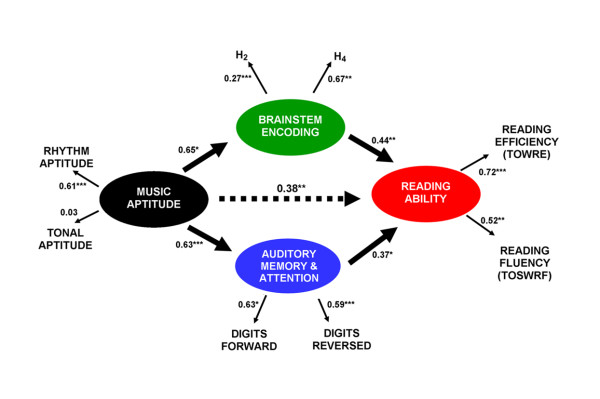
Structural equation model (SEM) of music aptitude, reading, auditory working memory/attention and auditory brainstem function. Music aptitude accounts for 38% of the variability in reading ability through its impact on auditory working memory/attention and subcortical enhancement of predictable speech harmonics. The model demonstrates an excellent fit; values plotted represent squared correlation coefficients (r2). *p < 0.05; **p < 0.01; ***p < 0.001.